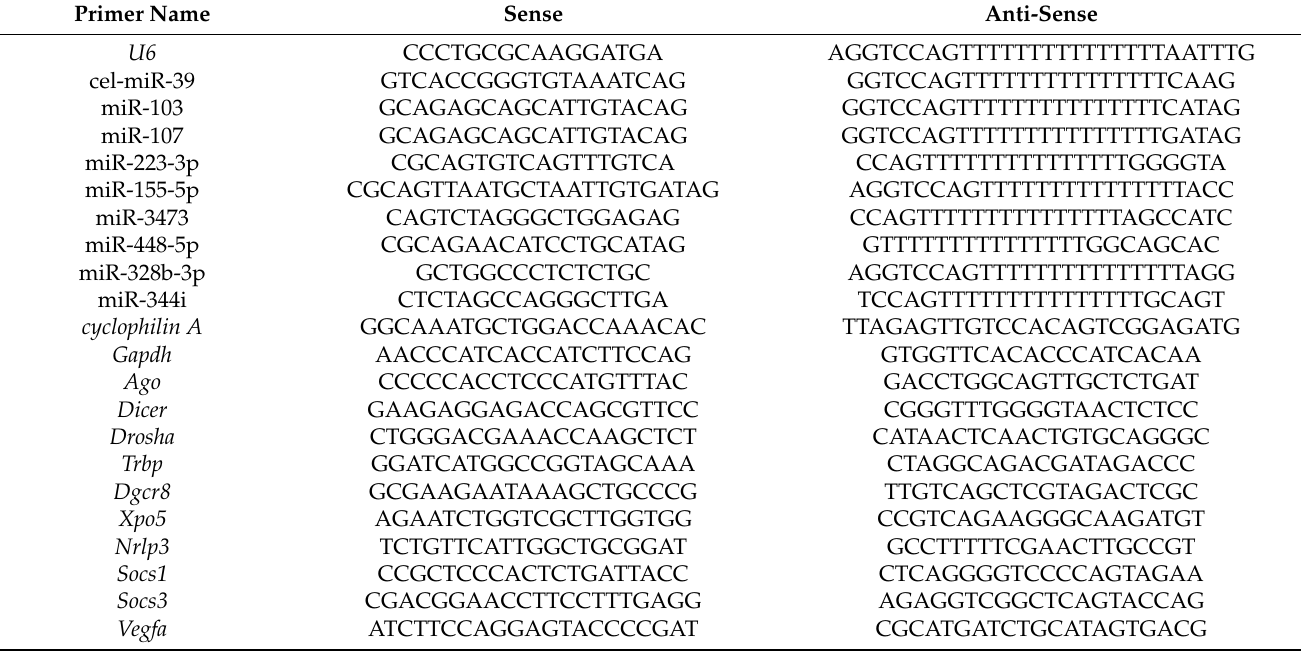
Table 1. List of primers used in this